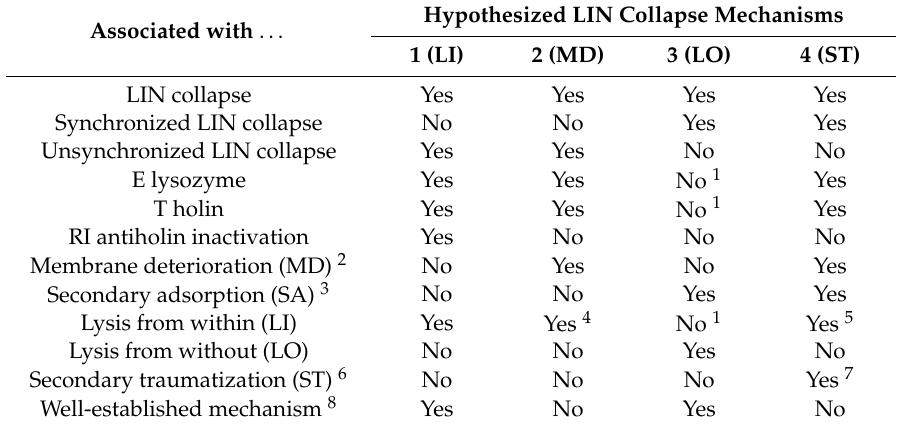
Table 4. Hypotheses Regarding the Mechanism(s) of LIN Collapse and its synchronization. Associated with